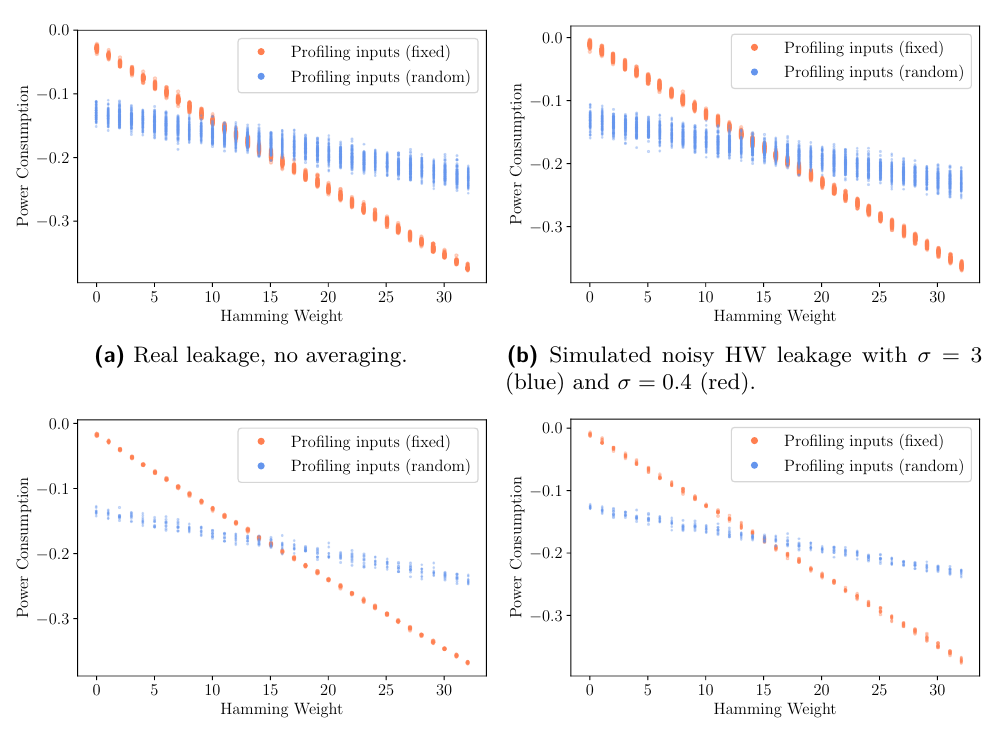
Figure 3: Real/simulated leakage of a STR instruction on a 32-bit STM32F405 when processing 32-bit words with a certain HW, while all other state bytes are set to fixed values (zeros) or randomly chosen. The value range of the simulated leakage is scaled so that it coincides with the real